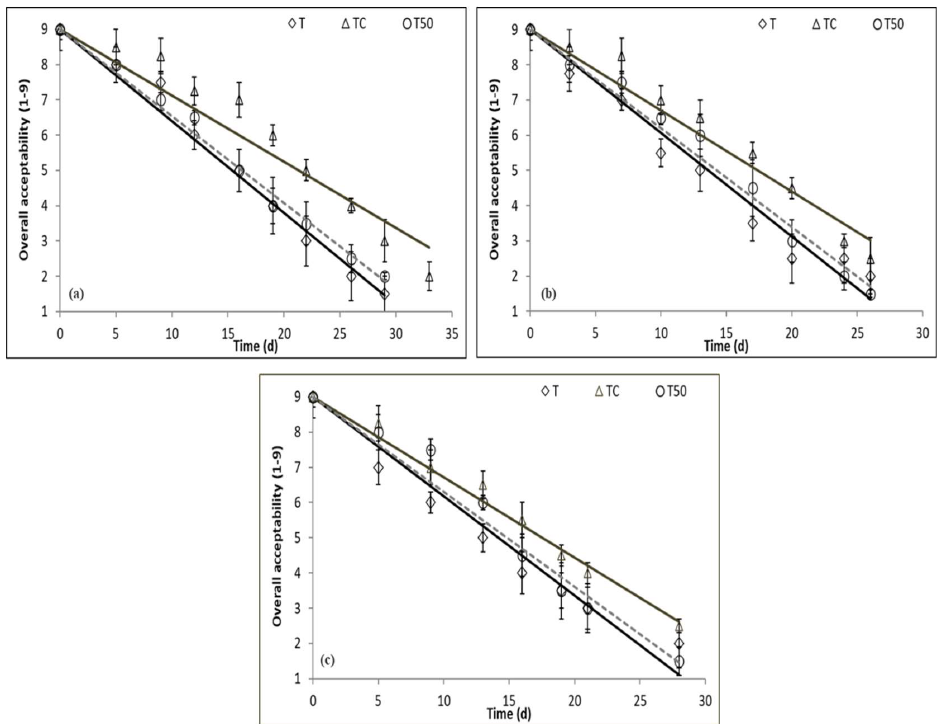
Figure 12. Scores of overall acceptability of sea bream samples slaughtered in ( a ) September 2020, ( b ) January 2021, and ( c ) April 2021 during storage at 0 °C ( ◇ T, △ TC, ○